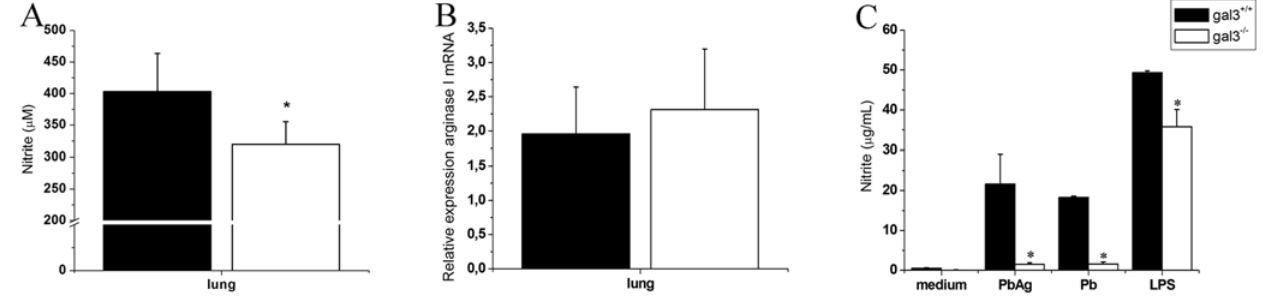
Figure 6. NO production (A) and arginase I levels (B) detected in the lungs of P.brasiliensis -infected mice and production of NO in vitro by peritoneal macrophages (C). In panel A, nitrite levels were detected by the Griess method in the lungs of mice, after 30 days of infection. The results represent the mean 6 SD of eight mice per group, from a representative experiment of three separate assays. Panel B shows transcript levels of arginase I mRNA in the lungs of mice, after 30 days of infection, determined by real-time PCR, using the b -actin gene as control. In panel C, nitrite levels were detected in the supernatant of adherent cells harvested from the peritoneal cavity of gal3 + / + (black bars) and gal3 2 / 2 (open bars) mice treated with thioglycollate. Cell cultures were incubated for 48 hours with medium alone or stimulated with bacterial LPS (1 m g/mL) or P. brasiliensis antigens (PbAg, 20 m g/mL) or P. brasiliensis yeast (Pb, 8 6 10 7 cells/mL). Each bar represents the mean 6 SD from a representative experiment of two assays. * P , 0.05, compared with infected gal3 + / + mice.